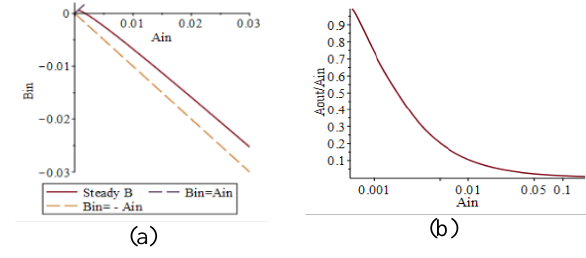
Fig. 5. (a): BIN, AIN relationship that satisfy B steady state condition. (b): corresponding gain for the harmonic